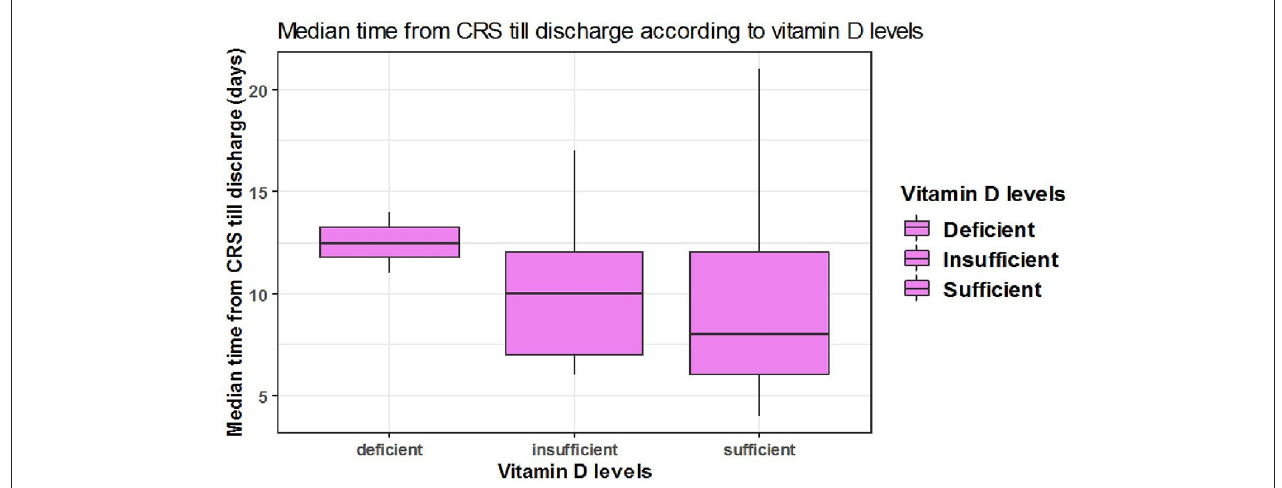
FIGURE 5 | The association between serum 25(OH)D levels (sufficient, insufficient, deficient) and median time CRS till discharge in days.